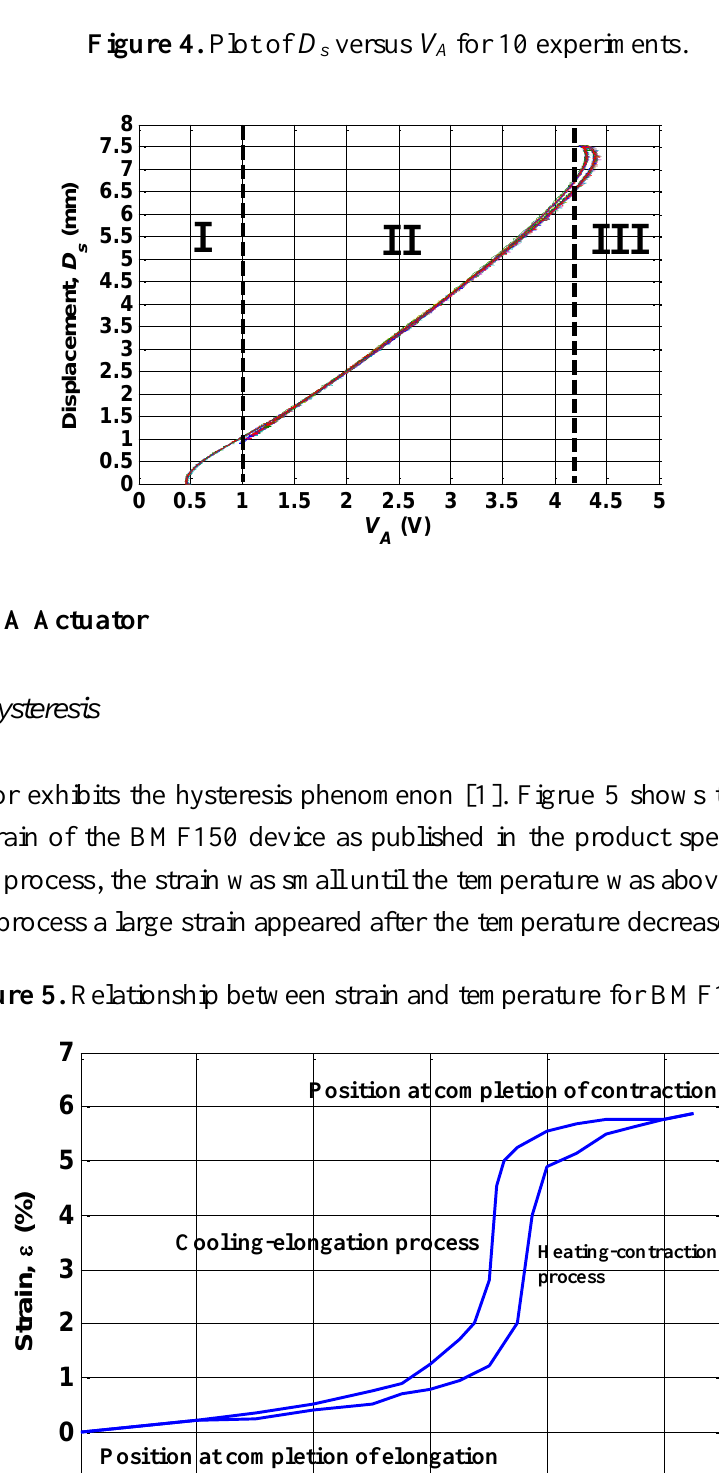
Figure 4. Plot of D